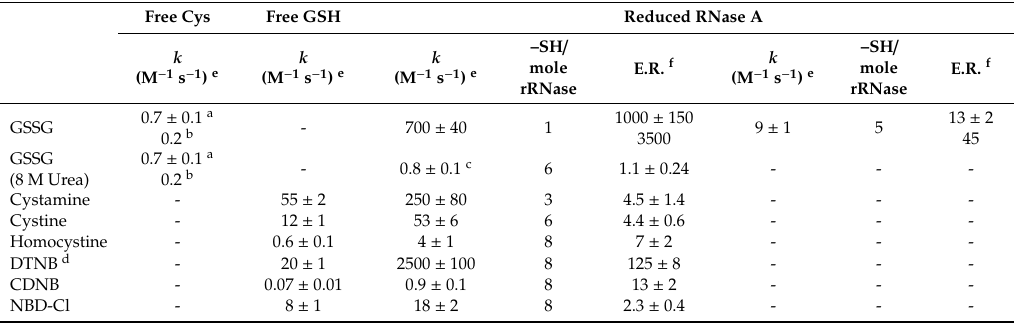
Table 1. Reactivity of rRNase cysteines toward disulfides and thiol reagents. Second-order kinetic constants k (M − 1 s − 1 ) for the reaction of cysteines of the rRNase, free Cys, and free GSH with natural disulfides and thiol reagents calculated at pH 7.4 and 25 ◦ C.